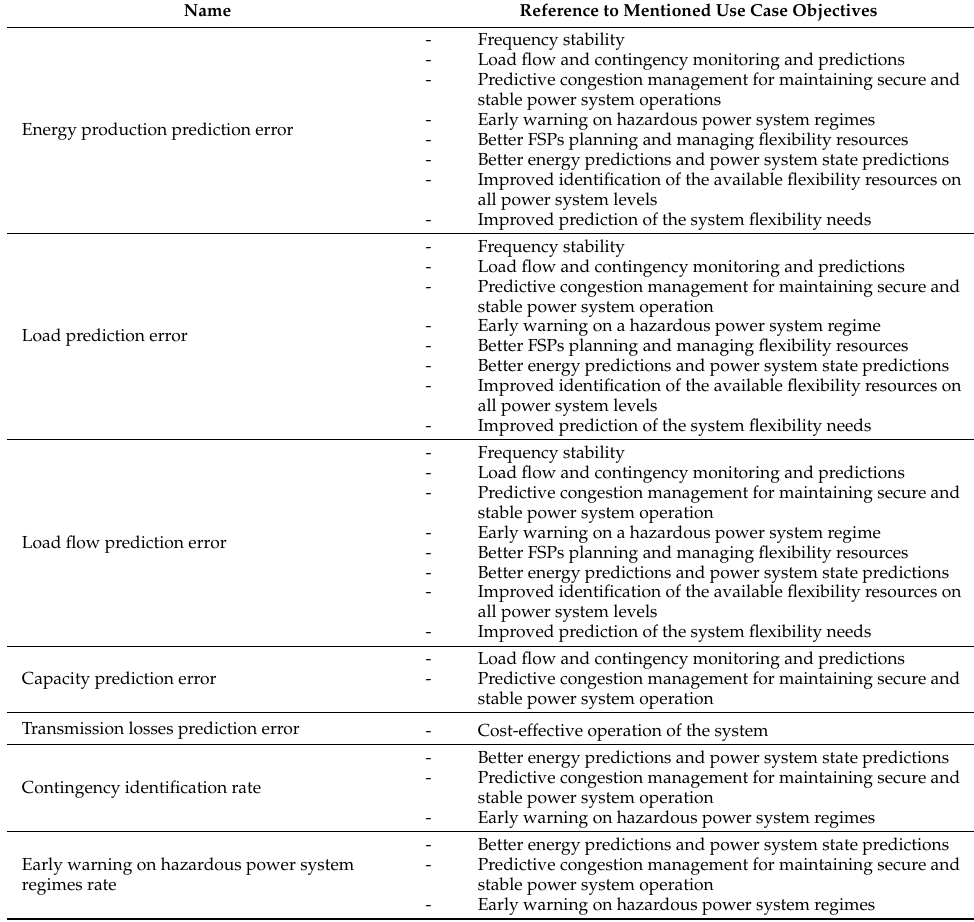
Table 2. Key performance indicators for the business use